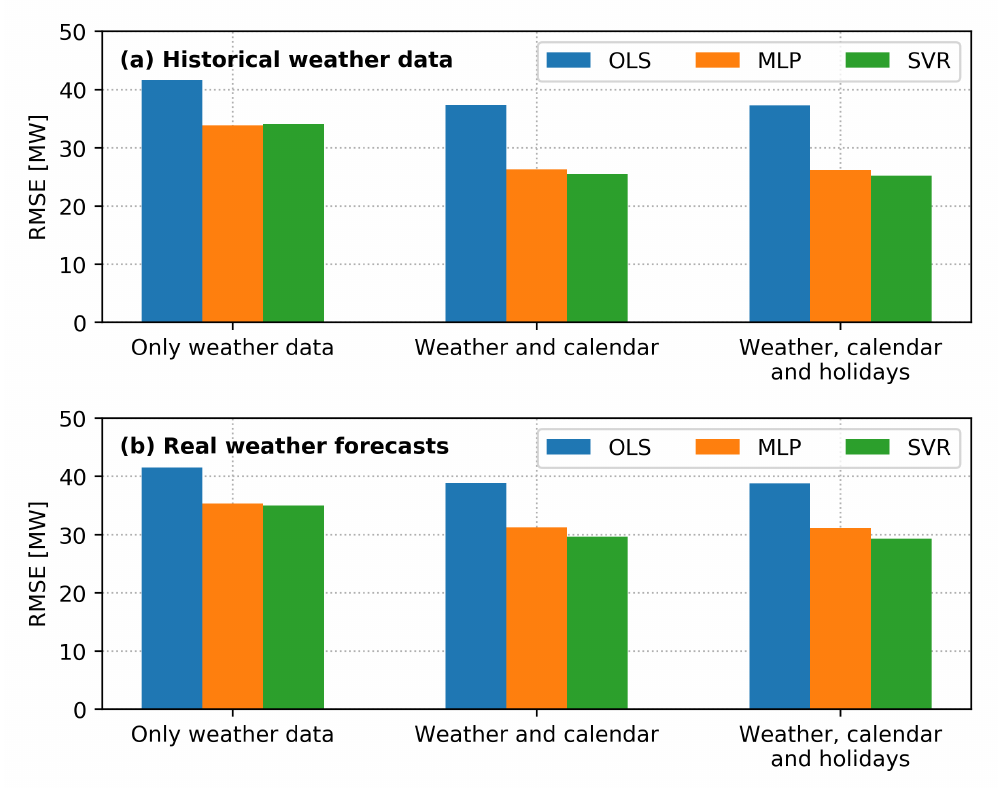
Figure 4. Root mean square error of the three forecast models OLS, MLP, and SVR on the year 2016. The top panel ( a ) shows the error using historical weather data to simulate 100% accurate weather forecasts. The bottom panel ( b ) shows the error using real weather